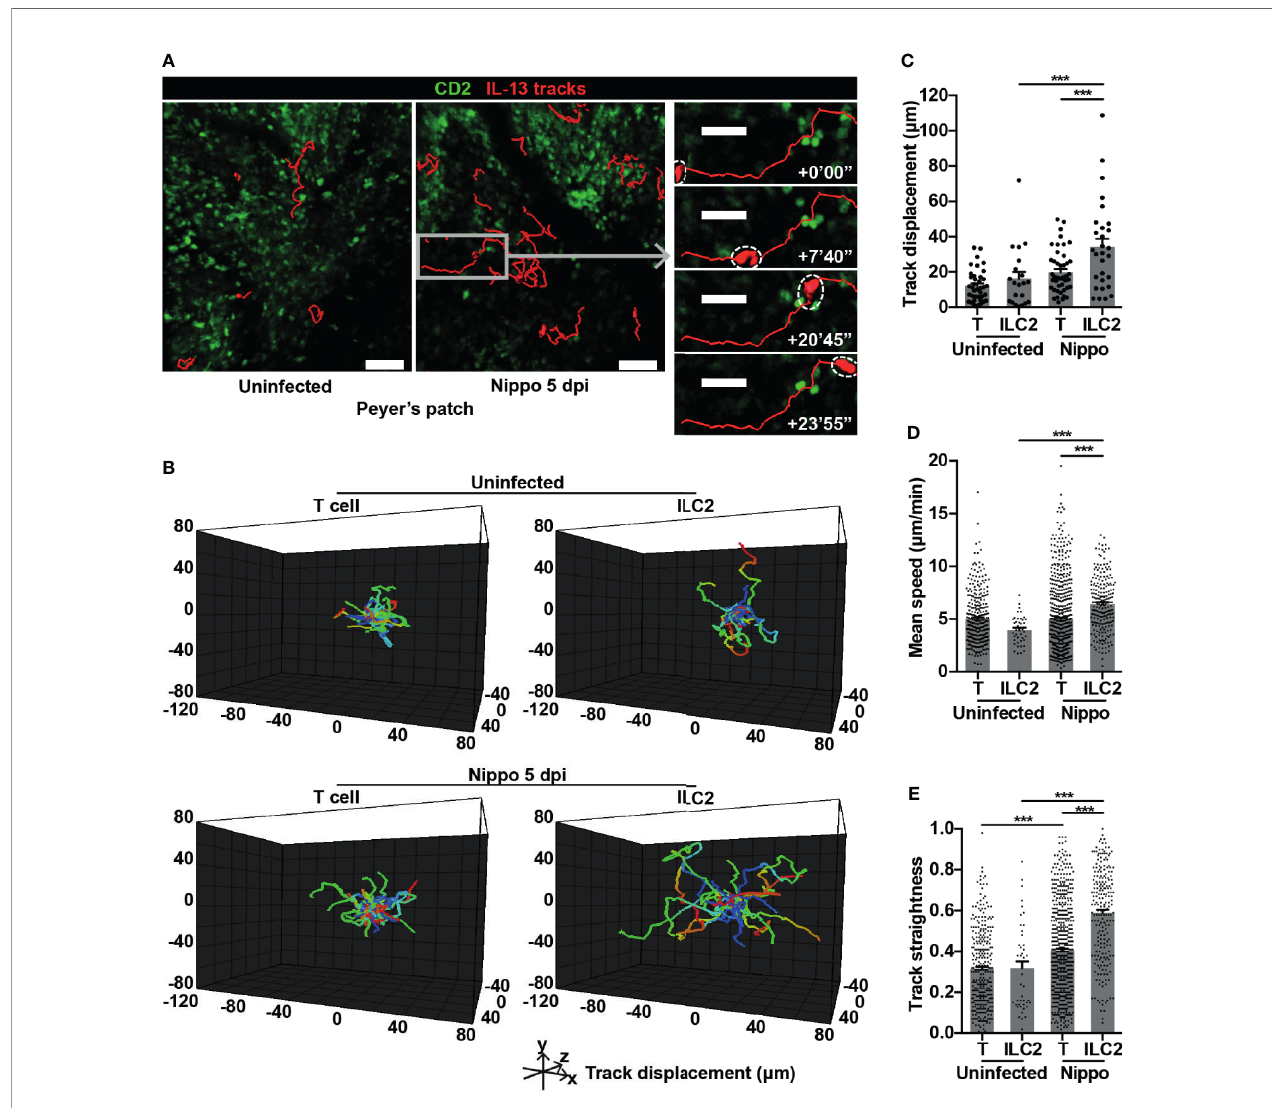
FIGURE 2 | PP ILC2s show altered movement following helminth infection. (A) Intravital images of ILC2 cell tracks in PP uninfected and 5 dpi, with inset showing example of prolonged cell track 5 dpi; scale bar 50 µm (inset 30 µm), Z 48 µm. (B) Cell tracks from one uninfected movie and one 5 dpi movie each 45 minutes in duration, with starting positions centralised. (C) Quanti fi cation of cell track displacement from (B) ; *** p < 0.001. (D, E) Quanti fi cation of (D) mean speed and (E) track straightness (directionality) of PP ILC2s and T cells; *** p < 0.001. Pooled data from 6-9 movies from 3 mice per condition, each dot representing one cell